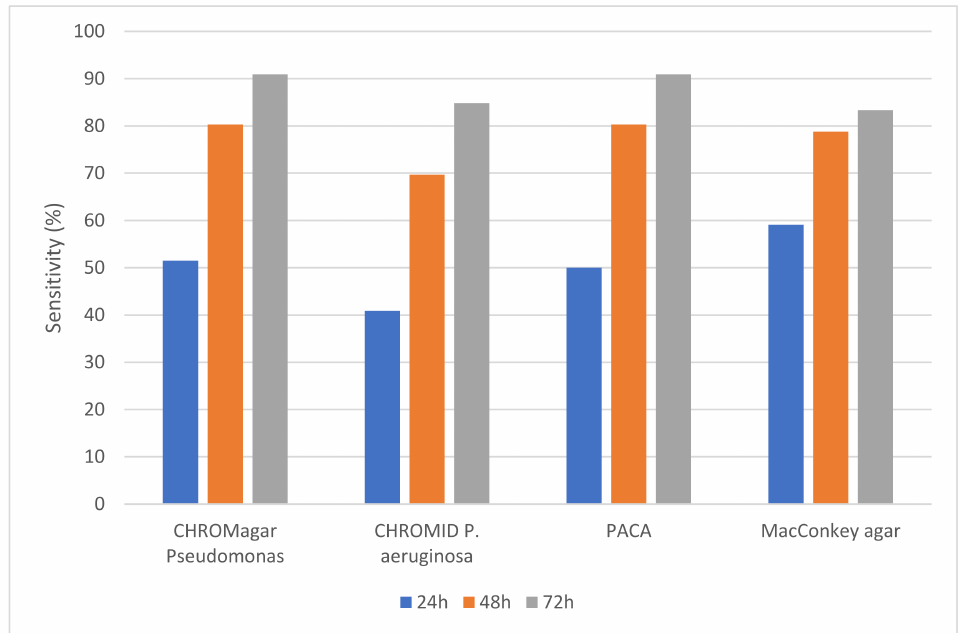
Figure 1. Sensitivity (%) of the four culture media for detection of P. aeruginosa from respiratory samples. Detection on the three chromogenic media depended on the generation of colored colonies (as detailed in Section 2.5).